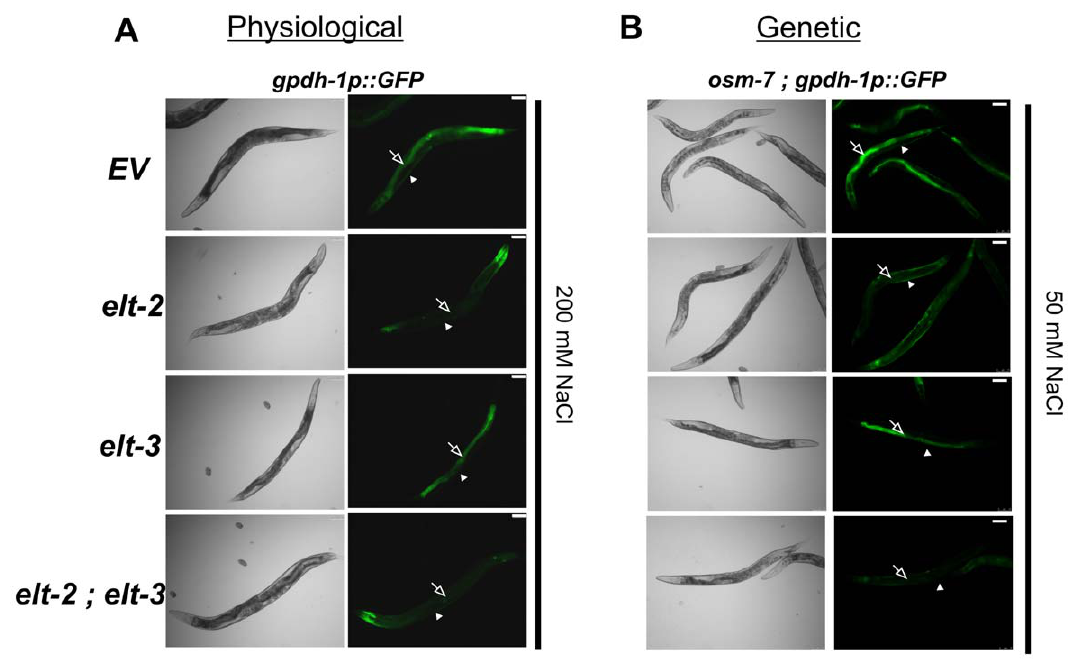
Figure 5. The GATA factors elt-2 and elt-3 mediate cell-type specific activation of gpdh-1 expression following physiological or genetic activation. (A) gpdh-1p::GFP animals exposed to the indicated RNAi treatments were exposed to 200 mM NaCl for 24 hours and GFP was imaged. Scale bar=75 m . (B) osm-7(n1515); gpdh-1p::GFP animals were exposed to the indicated RNAi treatments under isotonic conditions and GFP was imaged. Scale bar=75 m . Open arrows point to the intestine and closed arrowheads point to the